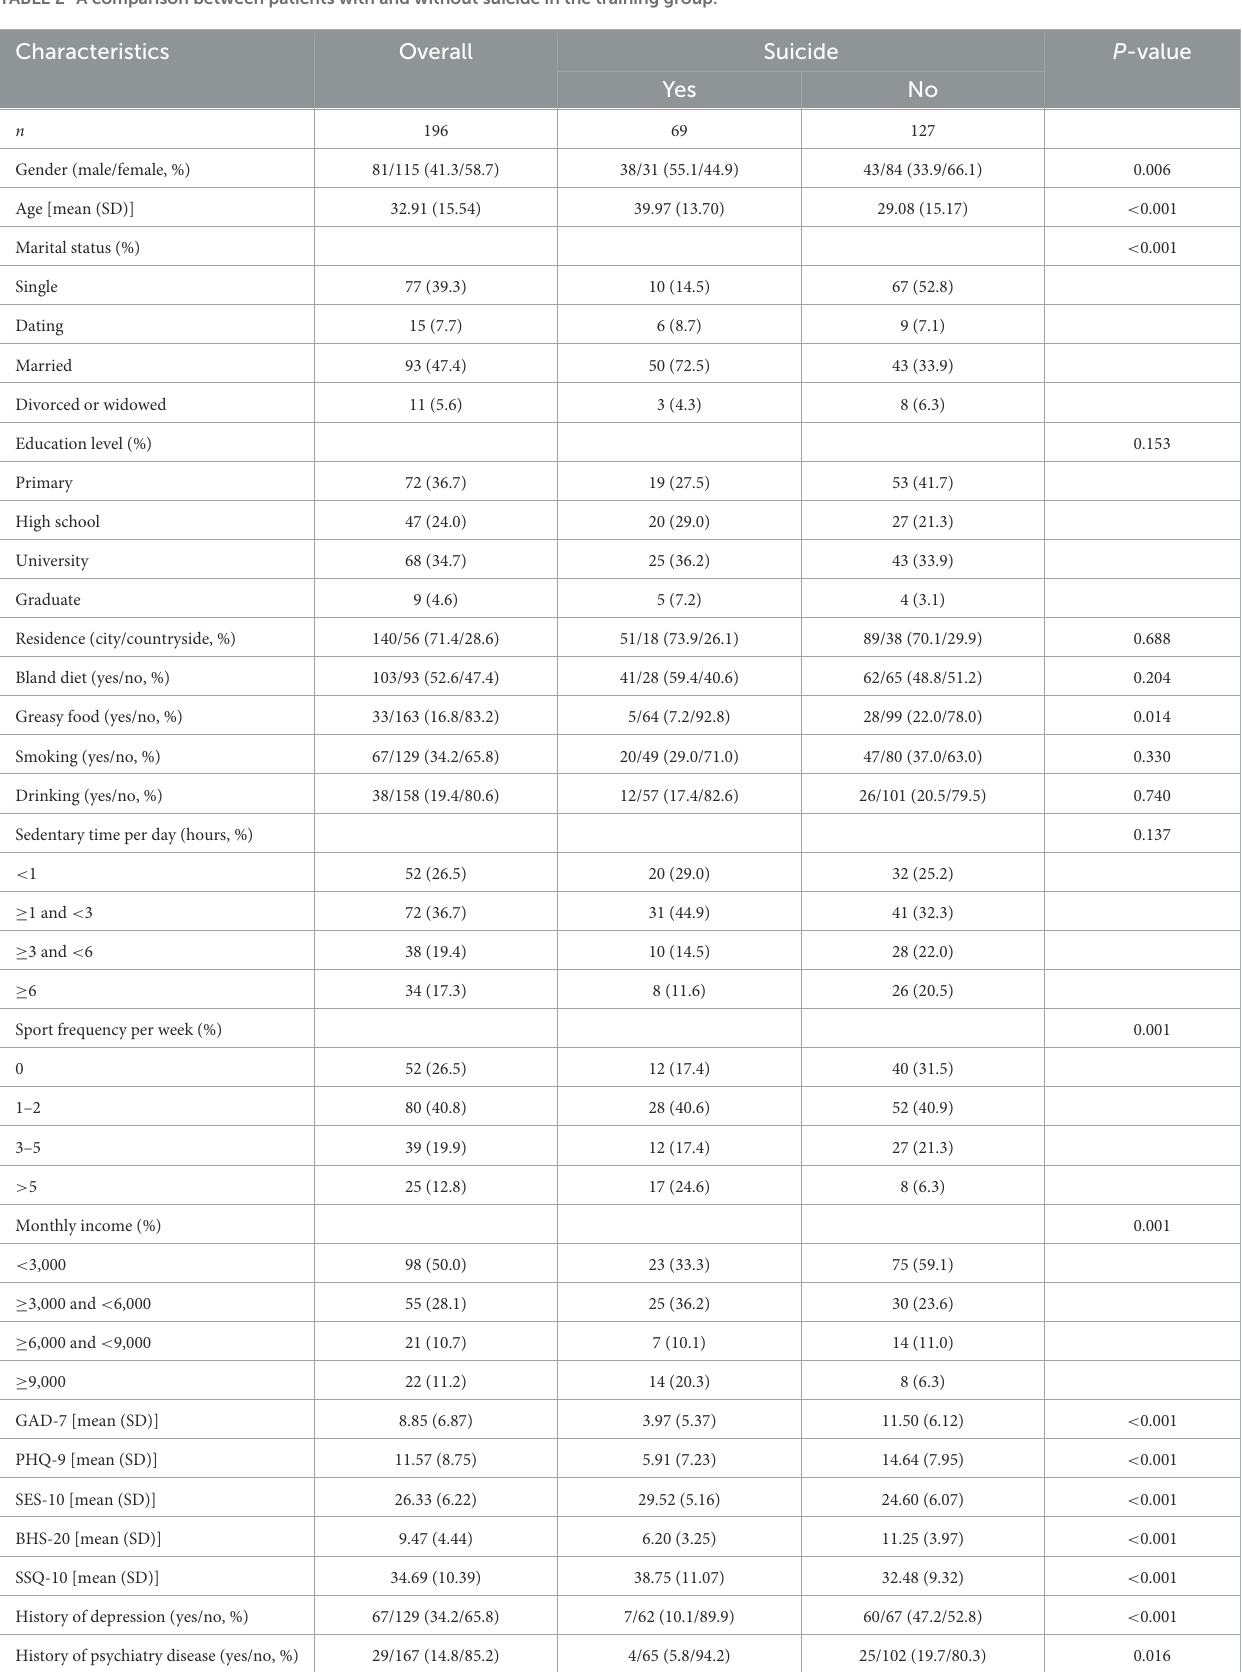
TABLE 2 A comparison between patients with and without suicide in the training group. Characteristics Overall Suicide P